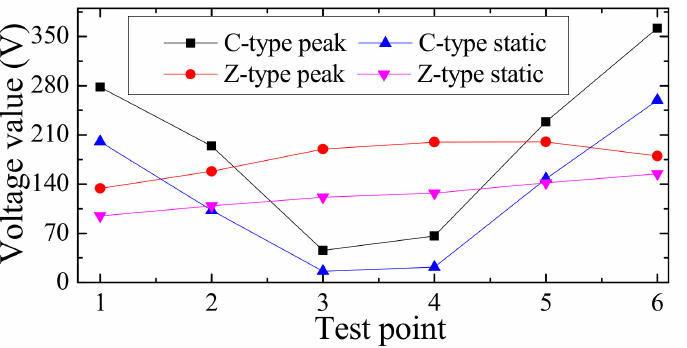
Figure 22. Peak and static interlayer voltage under different winding structures (tr = 200 ns, E r = 3.9). To display the difference between transient interlayer voltage simulation and static interlayer voltage analysis presented in the previous study [9], we added values of static voltage drop under different winding structures in Figure 22. Although the overall